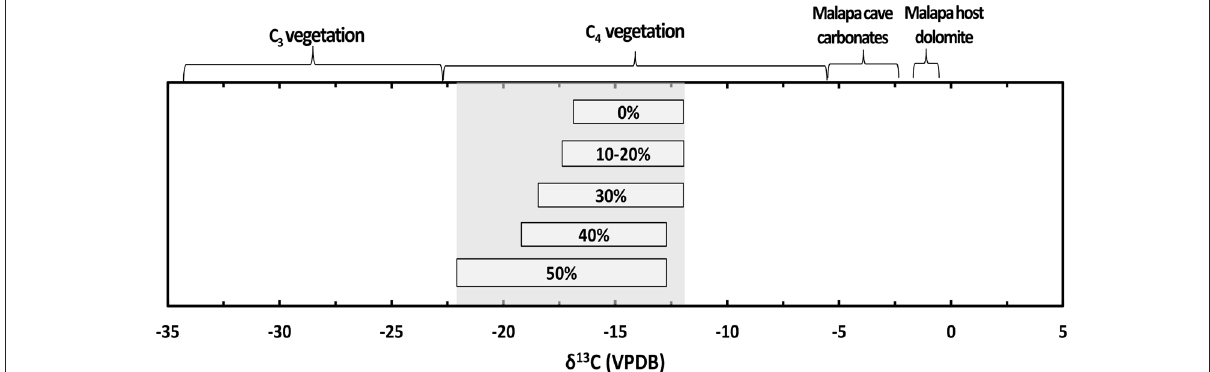
Figure 5: Calculated source δ 13 C values for Malapa according to host rock contribution. The percentage (0%–50%) of host rock contribution to the DIC pool determines the final value of source δ 13 C. The source of carbon from vegetation overlying Malapa at 1.977 Ma is dominated by C the host rock contribution to the DIC pool is 50% or less. If a higher contribution by the host rock is assumed, results indicate a greater contribution by C vegetation ( δ 13 C values for vegetation type as reported by Faure and Mensing 41 3